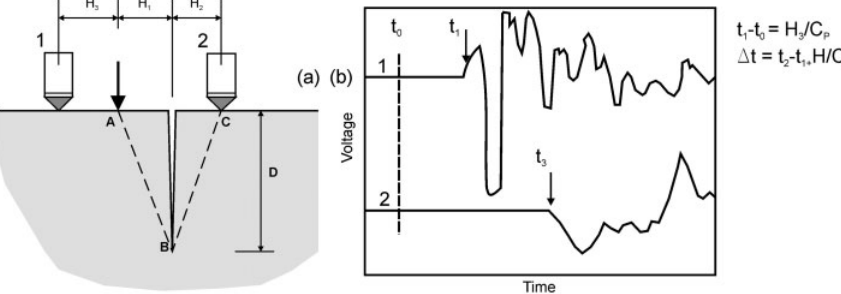
Fig. 7. Measurement of the opening crack depth: (a) scheme of the measurement; (b) sample waveform (Sansalone, Streett 1997) Table 3. Parameters used for testing the deck plate using Impact-Echo apparatus to determine the depth of cracks Velocity of wave in floor slab